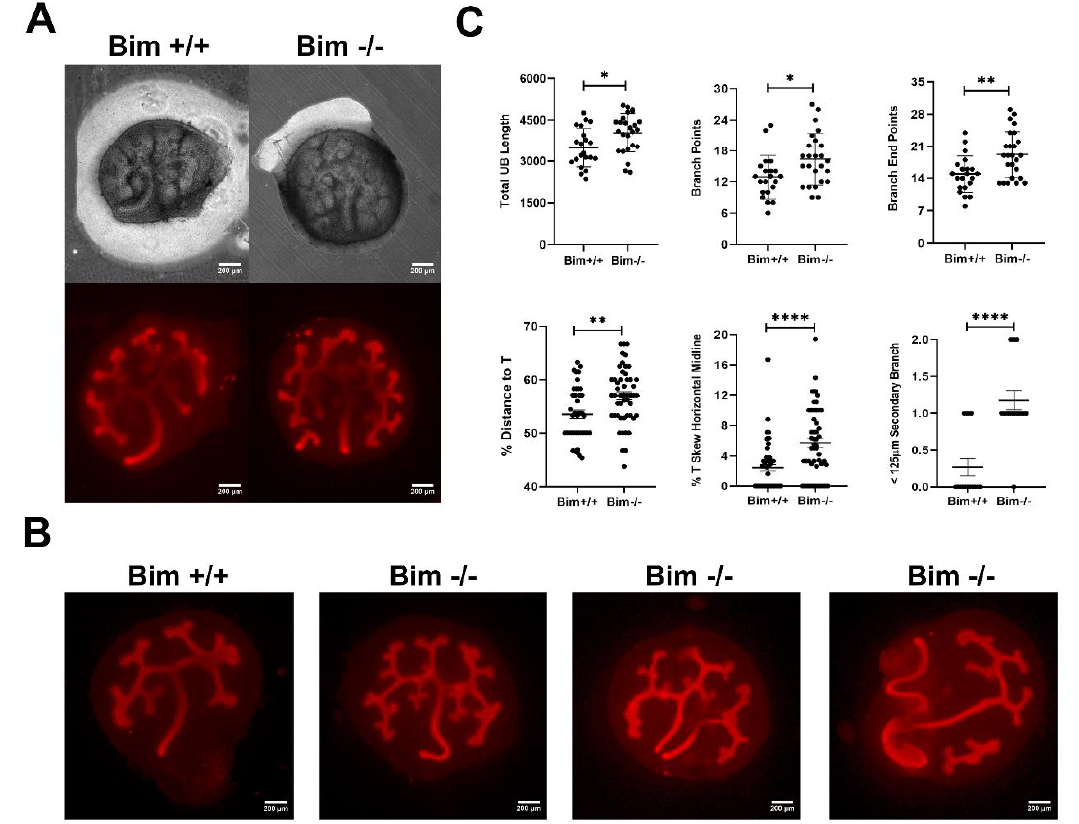
Figure 1. Enhanced ureteric bud branching in the absence of Bim. In Panel ( A ), phase images were taken of embryonic kidneys from E12 Bim +/+ and Bim −/− mice grown in culture for three days (upper panel), and then wholemount stained with anti-cytokeratin to visualize the ureteric bud (lower panel). Panel ( B ) are more representative images demonstrating some of the variation in ureteric bud branching noted in the absence of Bim. Panel ( C ) is the quantitation of total ureteric bud length, branch points, branch end points, percent distance to the T-branch, percent skew from midline of the T-branch, and number of secondary branches the occurred closer than 125 µm. Data are representative of 25 animals. Scale bar is 200 µm. p * < 0.05, p ** < 0.01, and p **** < 0.0001.